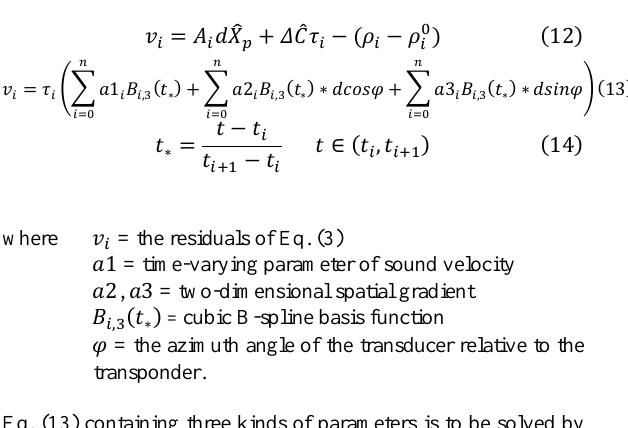
Figure 3 . Parameter correlation of circle configuration.